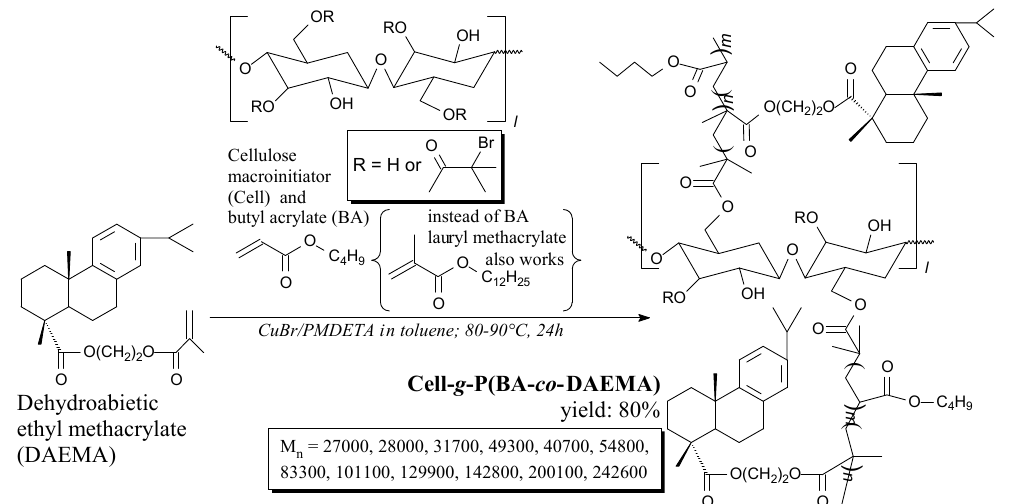
Scheme 58. Synthesis of graft copolymer of cellulose, rosin acid and butyl acrylate (or lauryl